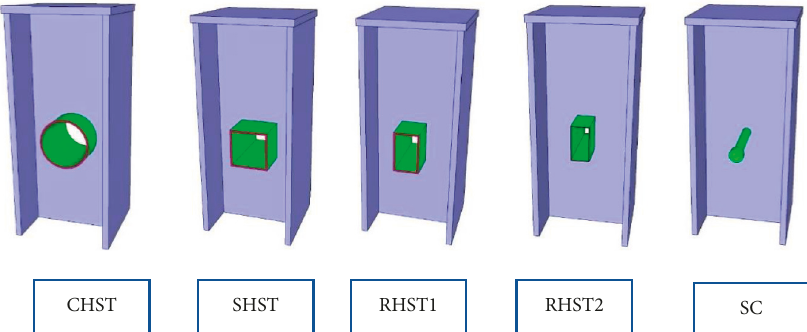
Figure 24: The steel beam and hollow tube shear